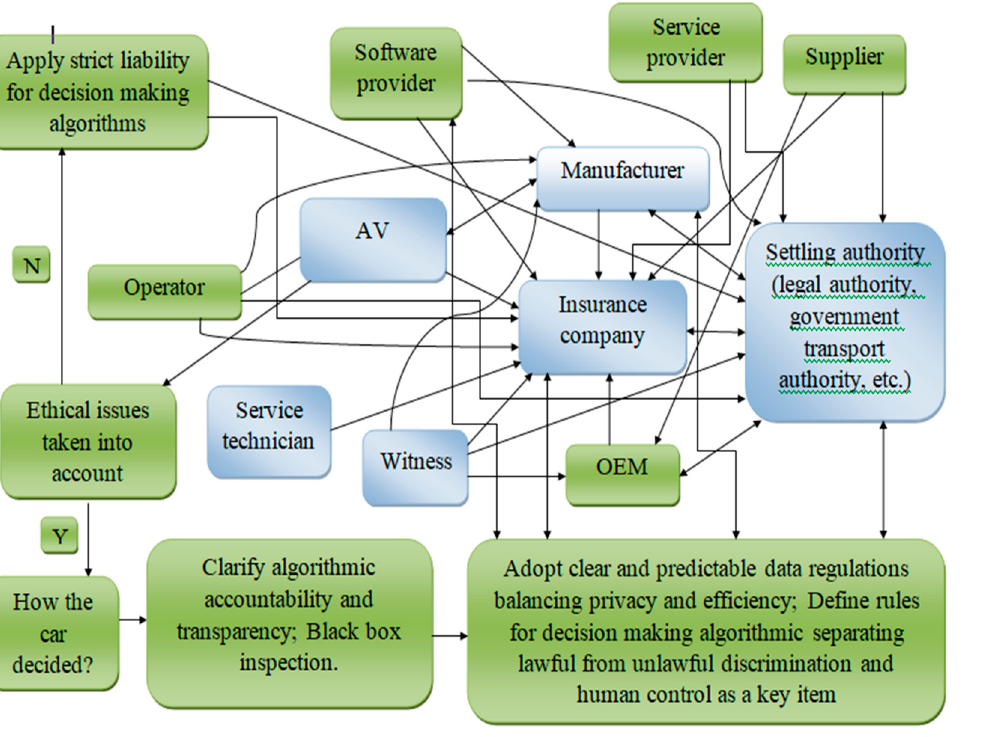
Figure 4. Proposed liability attribute model adapted from [49].